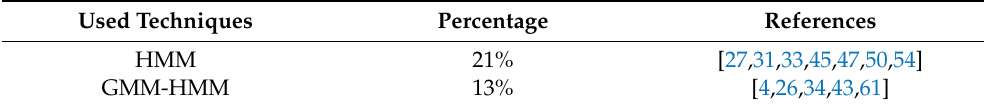
Table 9. The commonly used classification techniques. Used